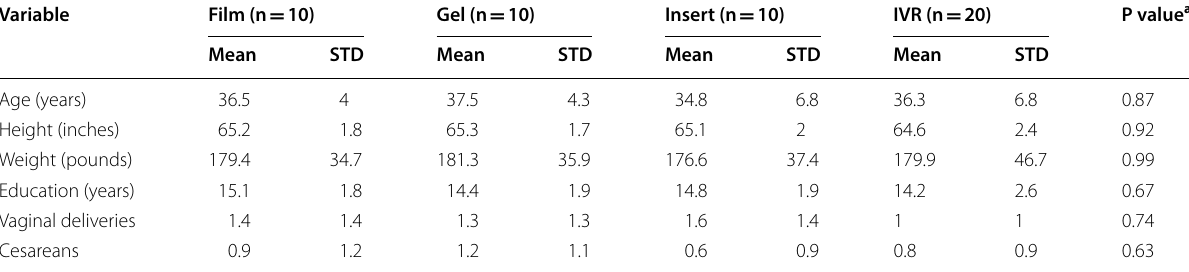
a P values were generated using Kruskal–Wallis test